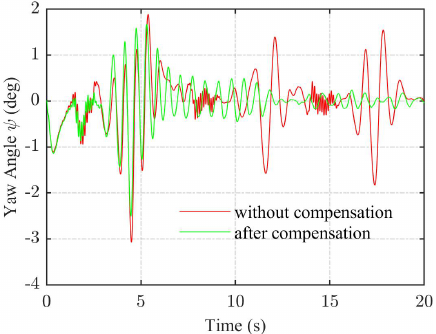
Figure 10. Effectiveness of the compensation term coping with motor